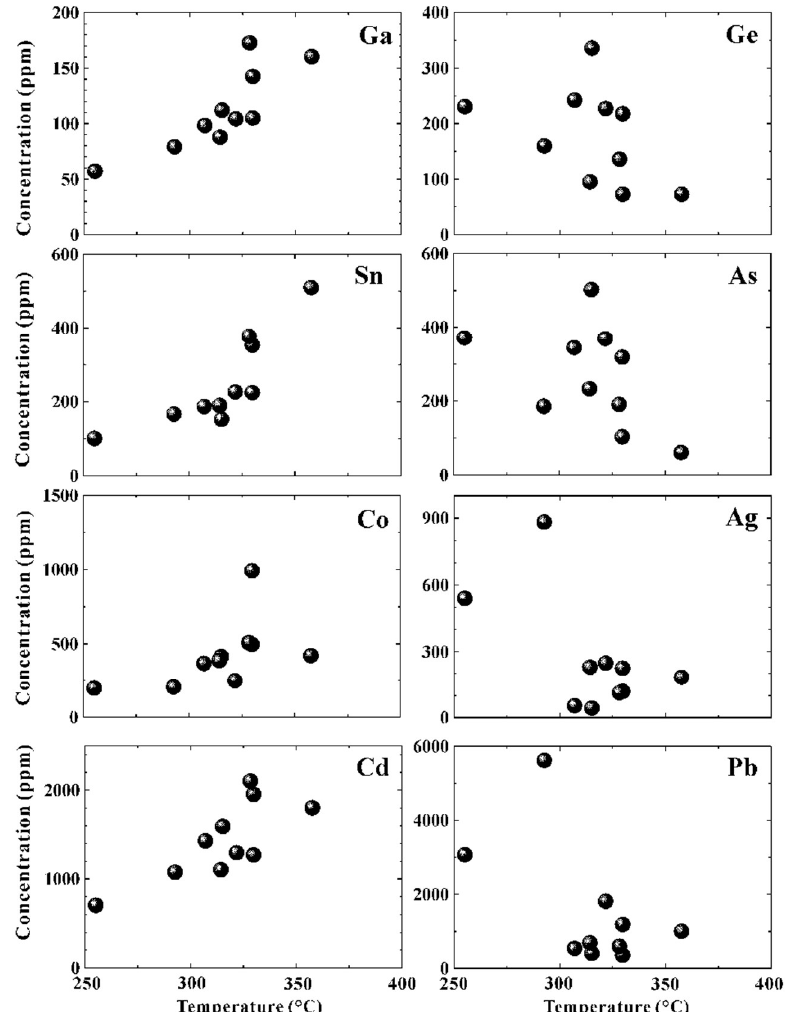
Figure 7. Correlation between the concentrations of trace elements in sphalerite and precipitation temperatures calculated from Keith et al. (2014) [53].